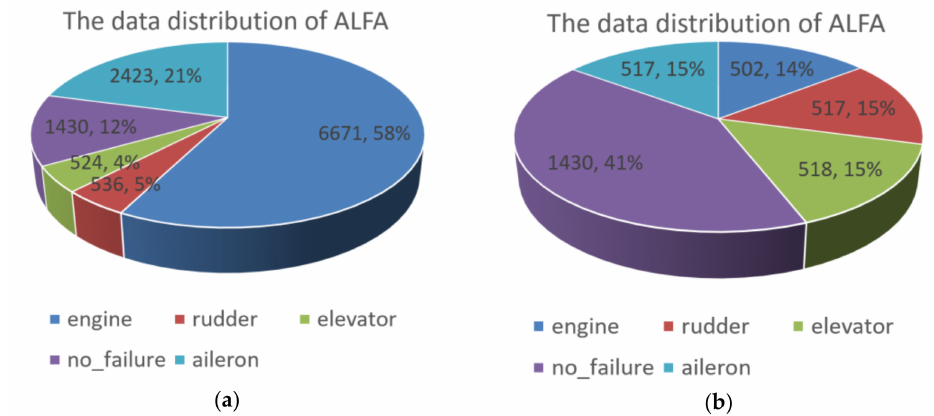
Figure 4. ( a ) The data distribution of ALFA. ( b ) The balanced ALFA.